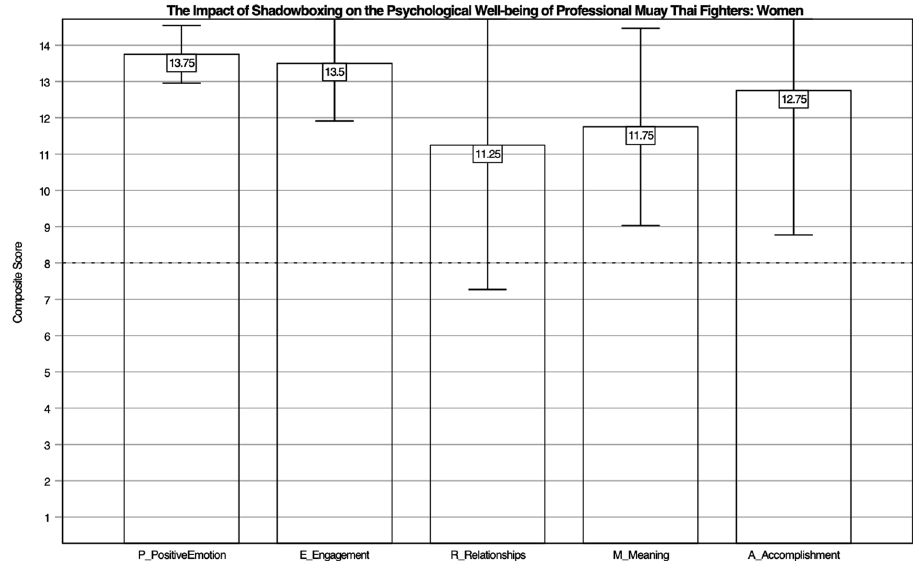
Fig. 3 This figure provides a bar plot with 95% confidence intervals (CIs) for composite PERMA scores: women (n = 4). For each element of psychological well-being, the lowest possible composite score is 2 representing that professional Nak Muays strongly agree that shadow- boxing negatively impacts that element of psychological well-being, whereas the highest possible composite score is 14 representing that professional Nak Muays strongly agree that shadowboxing positively impacts that element of psychological well-being. A composite score of 8 (dotted line) reflects a neutral position on whether shadowboxing contributes positively or negatively to that element. Results in this figure show that female Nak Muays strongly agree that shadowboxing positively contributes to all elements of their psychological well- being. Further, results in this figure show that shadowboxing contributes to the elements of psychological well-being in the following rank- order for women: positive emotions (P), engagement (E), accomplishment (A), meaning (M), and relationships